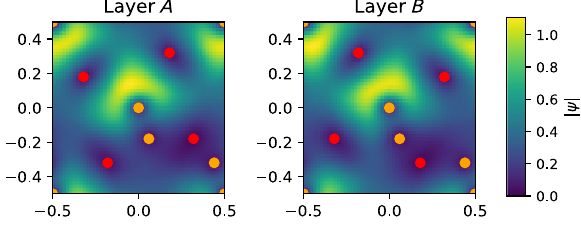
FIG. 7. Example wave function ψ obtained numerically k ¼ 0 from the Hamiltonian Eq. (45) with u ¼ 1 . 1 , ϕ ¼ 2 . 5 (at the flat band). Each layer has four mutual zeros, which are zeros of the entire wave function (in orange), and four zeros of opposite chirality which cancel the complex winding of the common zeros (in